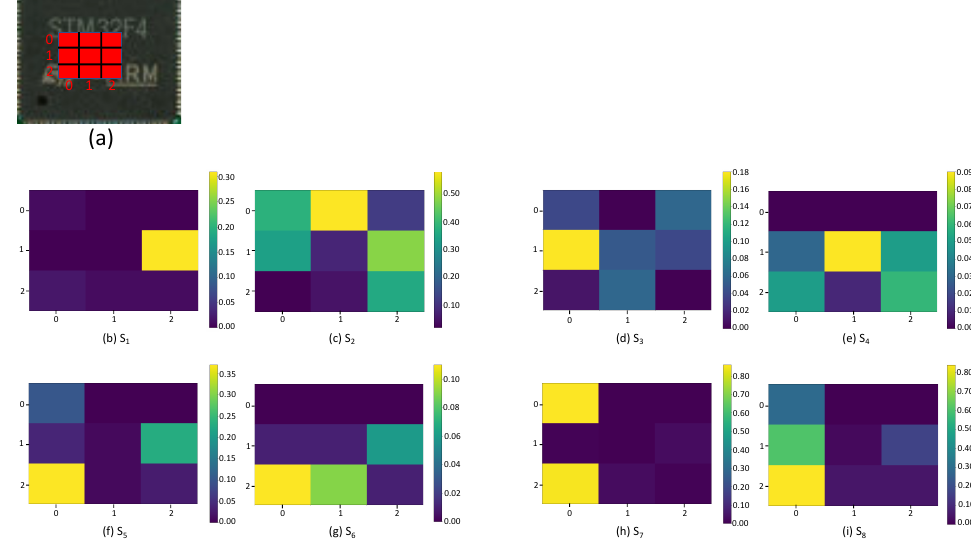
Figure 7: Sensitive area to EMFI for single faults (a) Physical location of sensitive spots to EMFI on the target chip (STM32F407VG) (b-i) Repeatability of Single Faults on the eight distinct Sboxes of